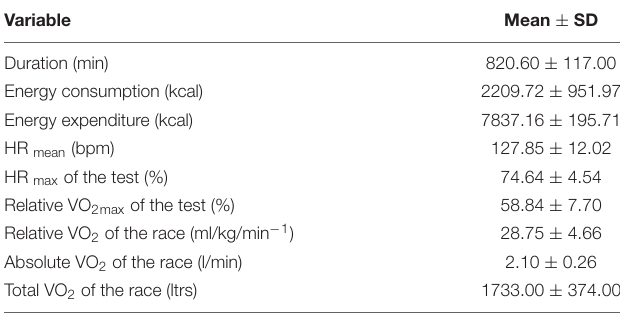
TABLE 2 | Participants variables measured during the ultramarathon ( n = 7).